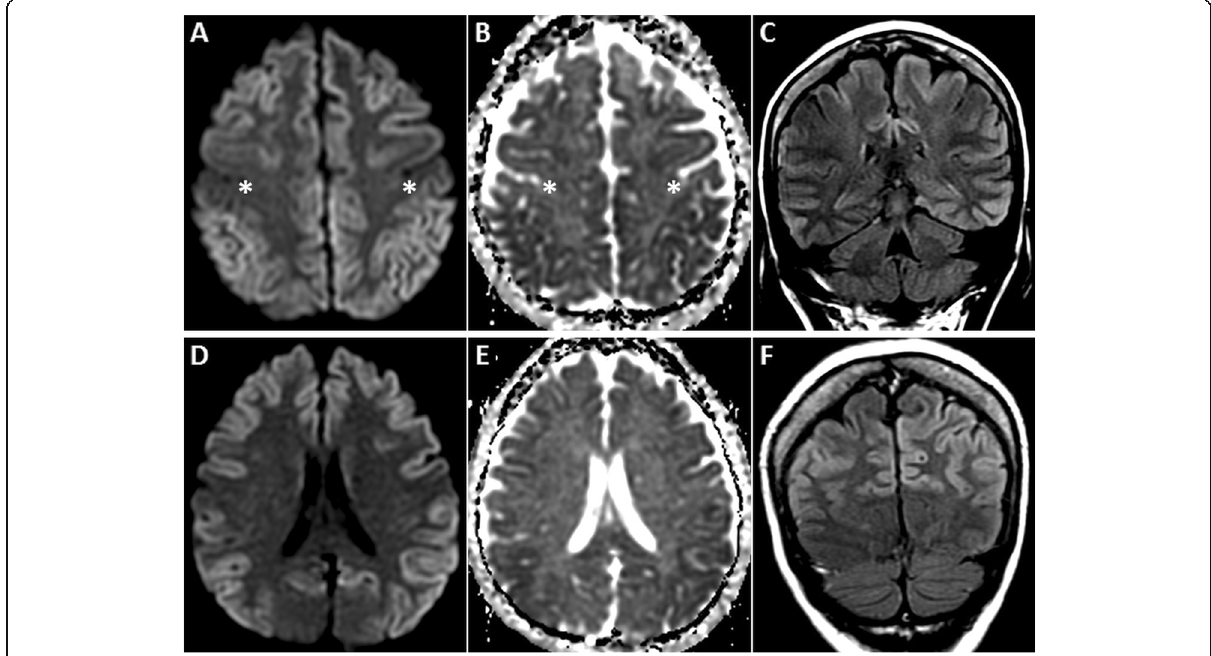
Fig. 9 MRI of the brain in a 58-year-old female patient who presented with rapidly progressive dementia due to sCJD. Symmetric GRD is seen in the cerebral cortices on axial DWI ( a , d ) and ADC images ( b , d , e ) with sparing of the perirolandic regions (asterisks in a , b ). Coronal FLAIR images ( c , f ) shows hyperintense signal in the affected cortices